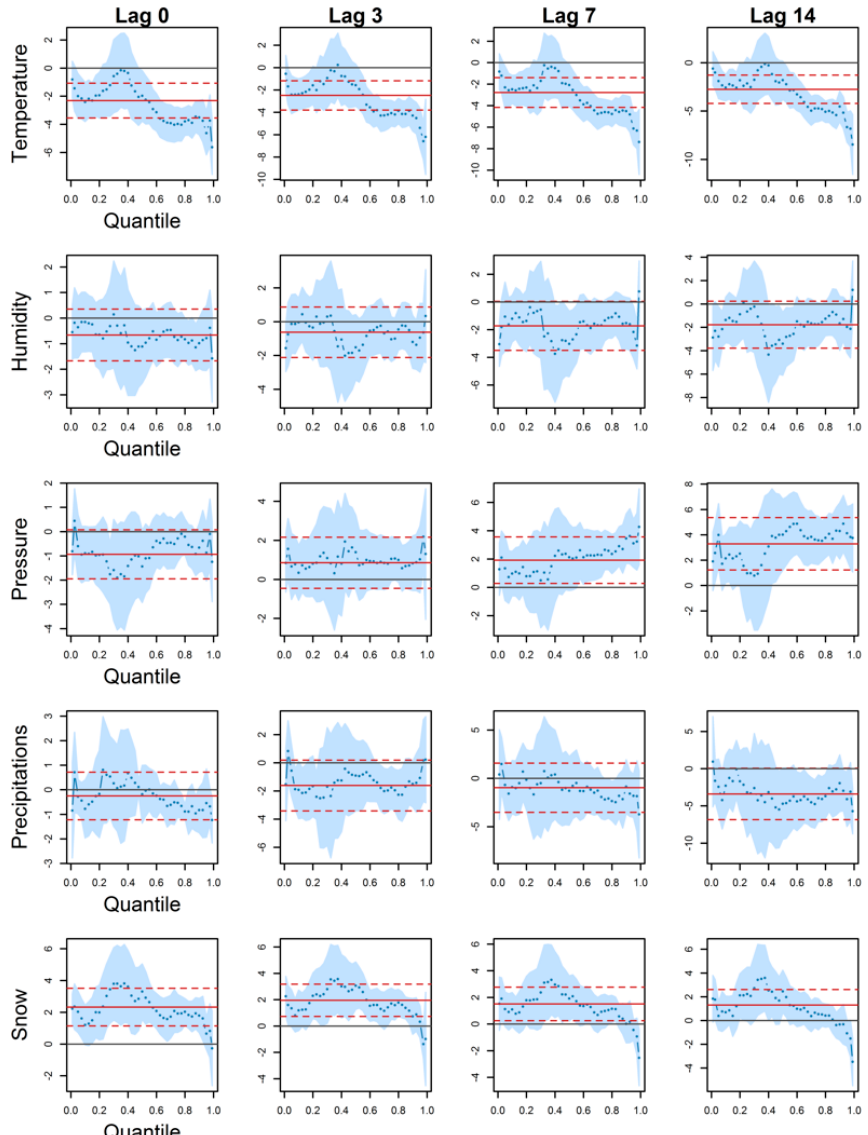
Figure 2. QR (blue dots) and classical mean regression (red full line) coefficients against quantiles, for hospitalizations in Montreal. 95% confidence intervals are shown in light blue for QR and in red dashed lines for classical mean regression.